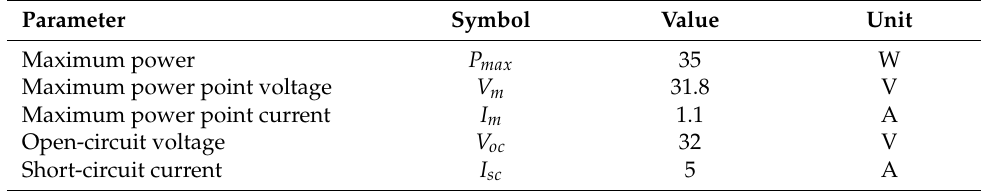
Table 2. PV emulator